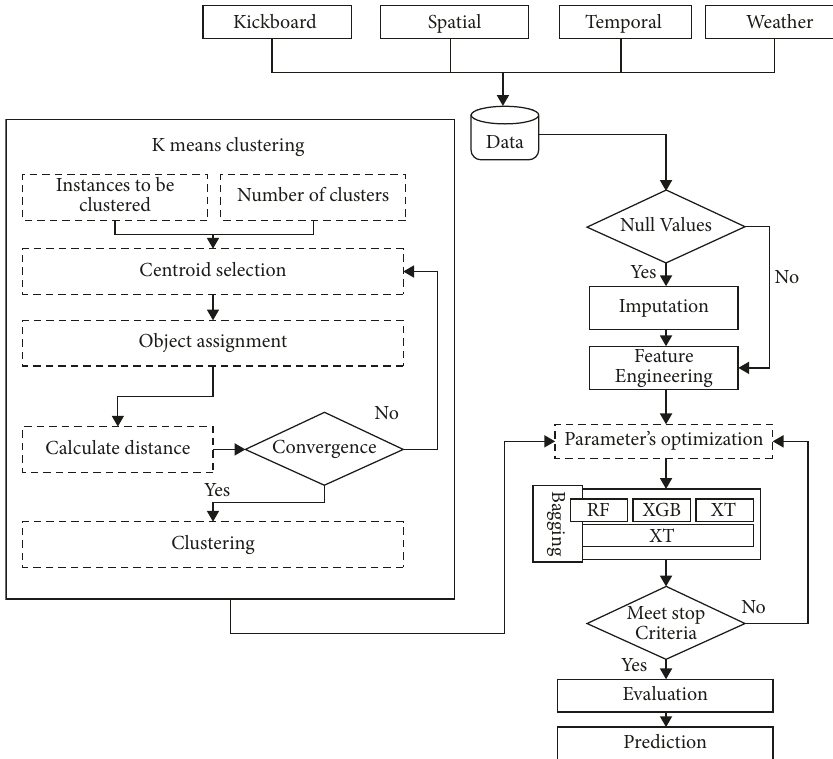
Figure 3: Flowchart of the proposed